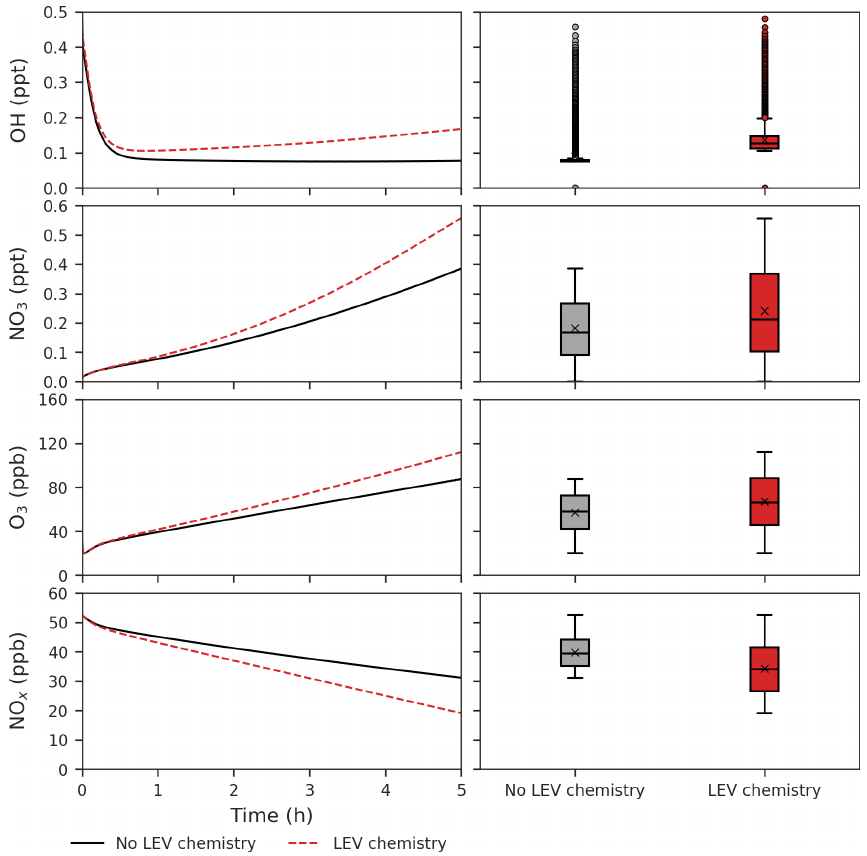
Figure 5. Effects of LEV chemistry on OH, NO 3 , O 3 and NO x (in red, relative to the case without LEV chemistry shown in black or gray). The time series represent averages of simulations performed with LEV chemistry (dashed red line) and without LEV chemistry (black line) over the 5h timescale. The box plots show the distributions of the species concentration for the entire 5h. Note that findings shown here are determined over a range of F values depending on experimental